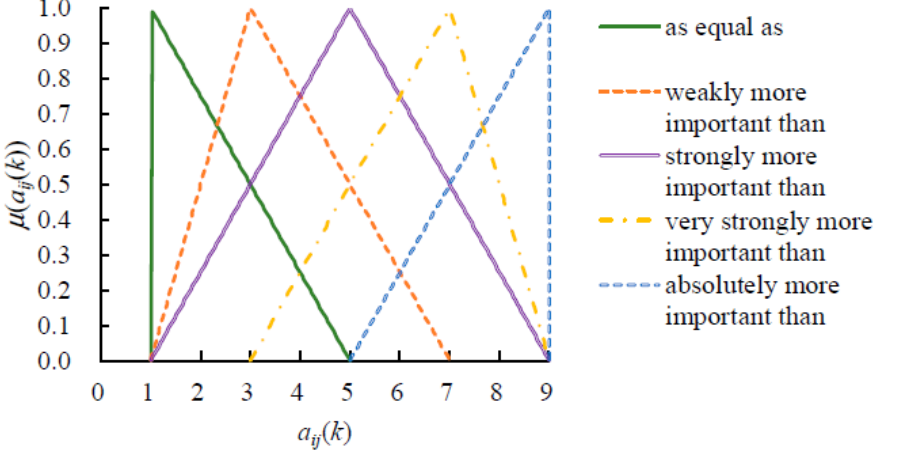
Figure 1. Fuzzy numbers used to derive fuzzy